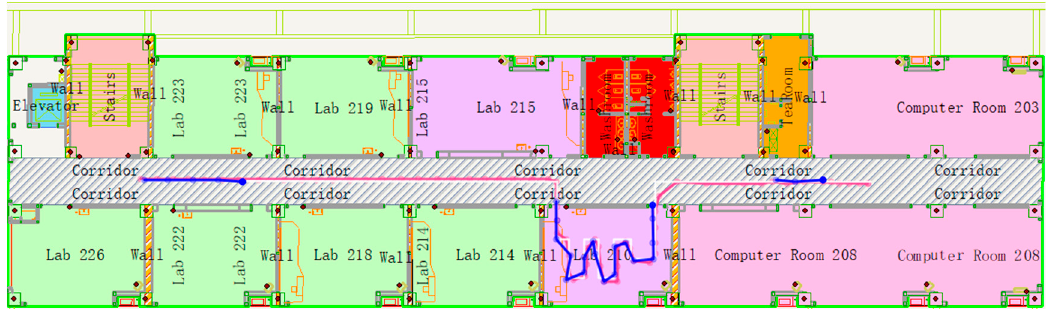
Figure 16. Pedestrian trajectory with UWB unlock in most of the corridor.